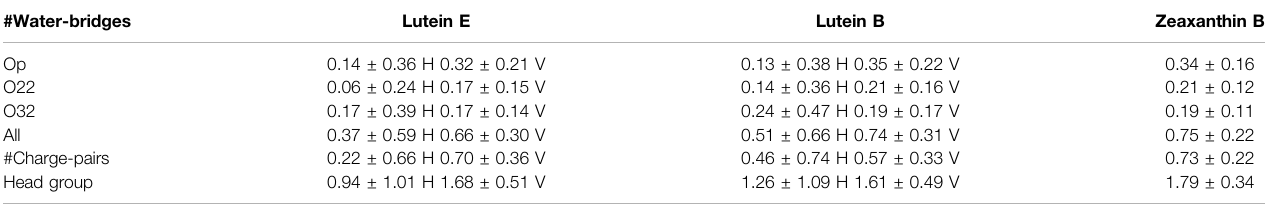
TABLE 2 | Time and ensemble average numbers of intermolecular interactions between a XAN-OH group and PC, per OH and per ps.